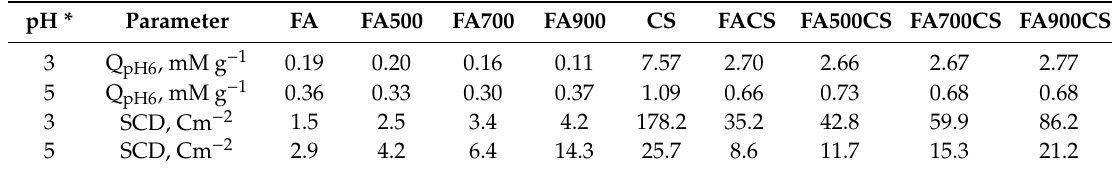
Table 4. Values of surface charge at pH = 6 determined from titration curves, Q pH6 .